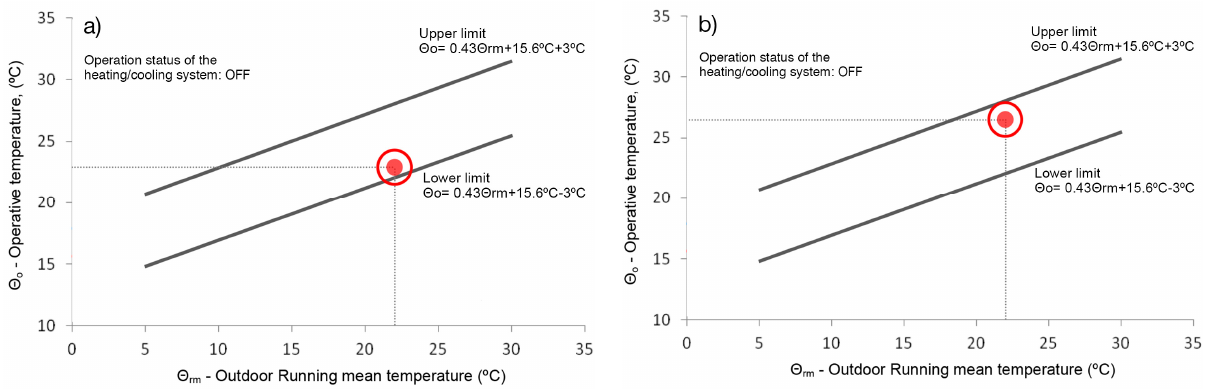
Figure 9. ( a ) Thermal comfort temperature (operative temperature) in the kitchen and living room during summer monitoring; ( b ) Thermal comfort temperature (operative